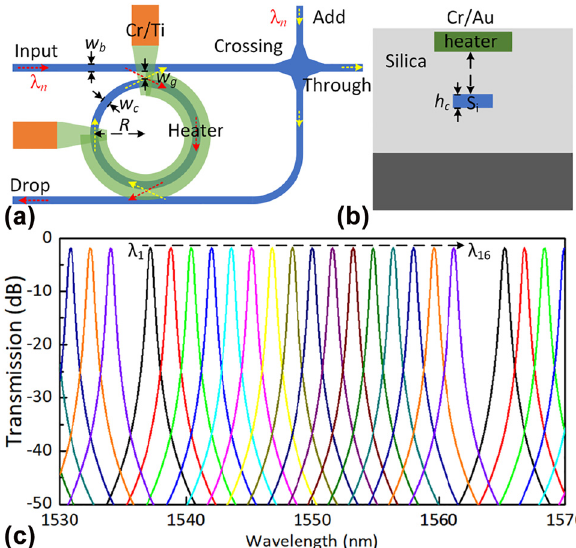
Figure 8: The MRR-based wavelength-selective switch. (a) The schematic diagram; (b) the cross-section of the MRR waveguide; (c) The calculated spectra for the drop port of the 16 MRRs in